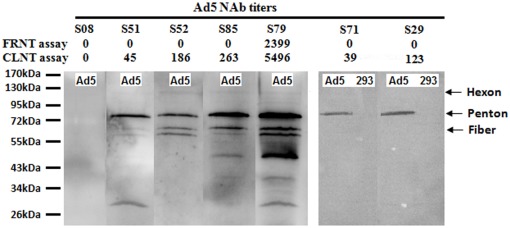
Confirmation of Ad5NAb by western blotting assay.Sample S08 was negative and S79 were positive for Ad5NAb titers for both assays. Samples S29, S51, S52, S71 and S85 were CLNT-positive/FRNT-negative sera. The uninfected HEK293 cells as negative control was used while two samples (S71, S29) were performed confirmation by western blotting assay. The Ad5 viral capsid is composed of three major types of proteins: hexon (130 kDa), penton base (82 kDa), and fiber (62 kDa).